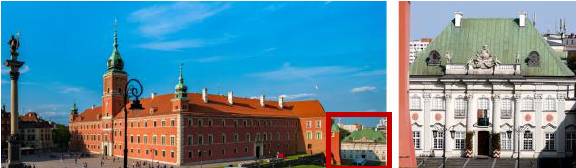
Figure 1. The Royal Castle in Warsaw with Tin-Roofed Palace